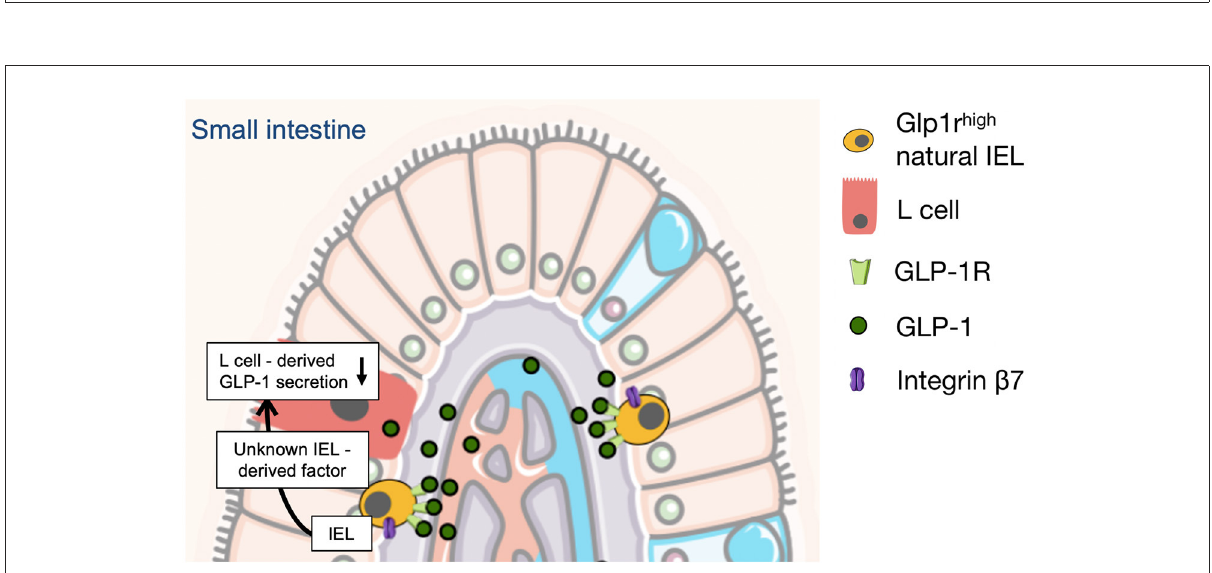
FIGURE2 L-cell derived GLP-1 secretion is controlled and limited by gut intraepithelial (IEL) lymphocytes in mice. This is mediated through a negative feedback mechanism in which gut IEL GLP-1 receptor activation directly inhibits L cell derived GLP-1 secretion through a still unknown IEL-derived mediator (32). The illustration was modified from Servier Medical Art